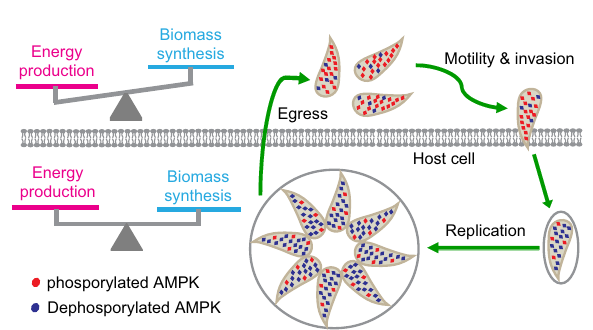
Fig. 8 | A model for the role of AMPK in reprogramming parasites ’ metabolic activitiesduringthelyticcycle. Releaseofintracellularparasitesintoextracellular environment induces AMPK α phosphorylation, which activates catabolism to generate energy and suppresses anabolism. At the extracellular stage, the activity of biomass synthesis is low but the parasites need ample energy to power motility for ef fi cient invasion into host cells. Once internalized in host cells, phosphoryla- tionofAMPK α isreducedandabalancebetweenenergyproducingcatabolismand biomass synthesizing anabolism is achieved, enabling robust proliferation of the parasites.